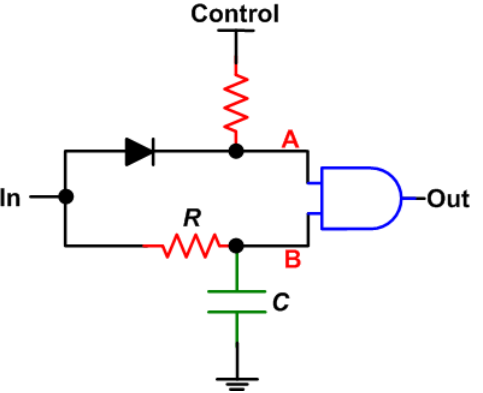
Figure 8. AND gate delay element, reproduced from